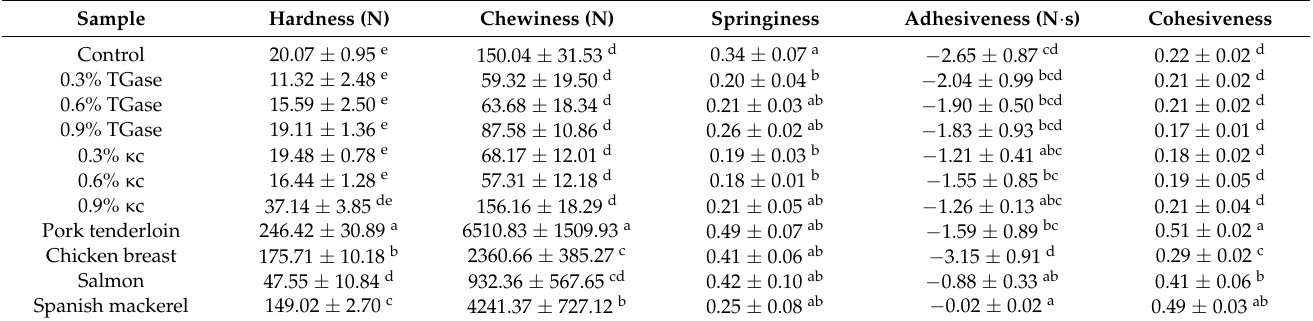
Table 2. Textural properties of cooked 3D-printed meat mimics treated by TGase and κ c at 0, 0.3, 0.6 and 0.9% as well as those of cooked animal